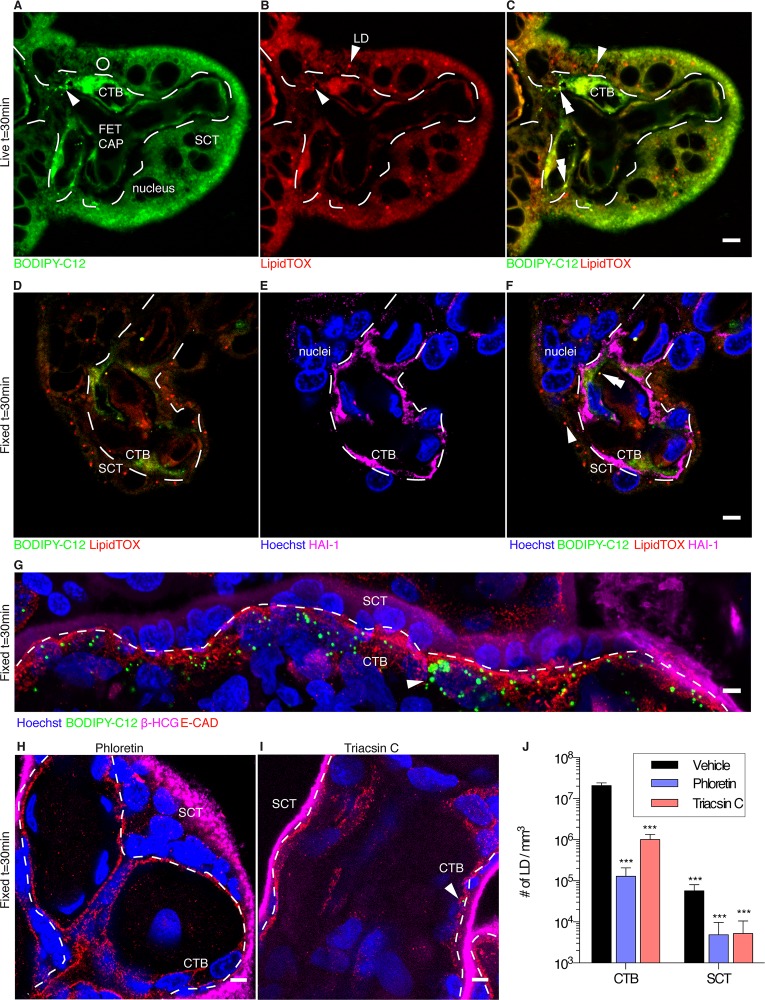
BODIPY-C12 fatty acid uptake in human term placental explants (30 min exposure).Dashed line represents the syncytiotrophoblast-cytotrophoblast interface. Co-localized BODIPY-C12 and LipidTOX forms yellow LD, indicating esterified BODIPY-C12. (A) BODIPY-C12 (green) is localized to punctate structures (arrow heads) and diffuse areas in syncytiotrophoblasts (SCT) and cytotrophoblasts (CTB). Dark “holes” are unstained nuclei. (B) Pre-existing neutral lipids (LipidTOX, red) are found in punctate structures which are lipid droplets (LD) (arrow head); (C) LipidTOX co-localizes with BODIPY-C12 (double arrowhead) predominantly in CTB, providing evidence that BODIPY-C12 is esterified and localized within LD. Conversely, in SCT, LD (arrowhead) contains little BODIPY-C12 (corresponding region 2A open circle). (D-F) images of explants after fixation showing BODIPY-C12 (green) and LipidTOX (red). (D) LD are present in both SCT and CTB, but BODIPY-C12 seen in (A) has mostly washed out in processing but some remain in sequestered organelles. (E) Hoechst (blue) marks nuclei and HAI-1 (magenta) marks CTB, (F) BODIPY-C12 (green) is found primarily in CTB (magenta) but not in SCT (see double arrow head). (G) BODIPY-C12 containing lipid droplets (arrow heads) are found extensively in the CTB layer (e-cadherin, red) but are sparse in the SCT layer. (H) phloretin (a blocker of protein mediated transport), and (I) triacsin C (a blocker of long-chain fatty acyl-CoA synthetases) reduces the population of lipid droplet containing BODIPY-C12 in CTB. These experiments suggest that transporters and acyl-CoA synthetases are required for production of LD. (J) Quantification of lipid droplets synthesized in explants illustrating the effects of chemical inhibitors and shows under control conditions BODIPY-C12 LD accumulation is higher in 30 min in the CTB vs. SCT; (I): Data are mean ± SEM; n = 6 control, n = 5 phloretin, and n = 4 triacsin C. 2-way ANOVA, *** = p<0.001 vs CTB vehicle; VS, villous stroma; FET CAP, fetal capillary; Scale Bar: 5μm.